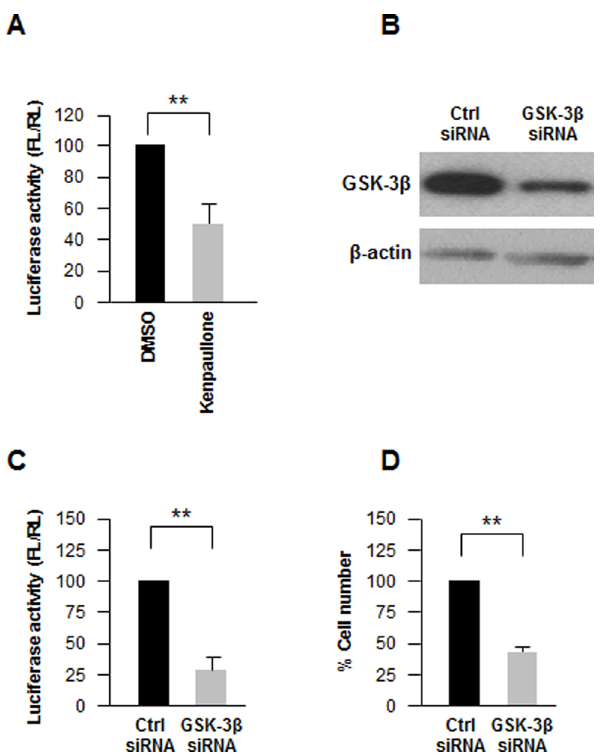
Figure 2. GSK-3 b inhibition or silencing decreases reporter activity. ( A ) Five hours after transfection with pmirGLO-let7, BG-1 cells were treated with GSK-3 b inhibitor Kenpaullone (10 m M) or with vehicle control (DMSO) and luciferase activity was measured 24 h later. ( B ) Forty-eight hours after transfecting BG-1 cells with 100 nM Ctrl siRNA or GSK-3 b siRNA, lysates were prepared to assess the levels of GSK-3 b or loading control b -actin by western blot analysis. ( C ) Twenty-four hours after transfection with 100 nM Ctrl siRNA or GSK-3 b siRNA, BG-1 cells were transfected with pmirGLO-let7 and luciferase activity was measured 24 h later. ( D ) Forty-eight hours after transfection